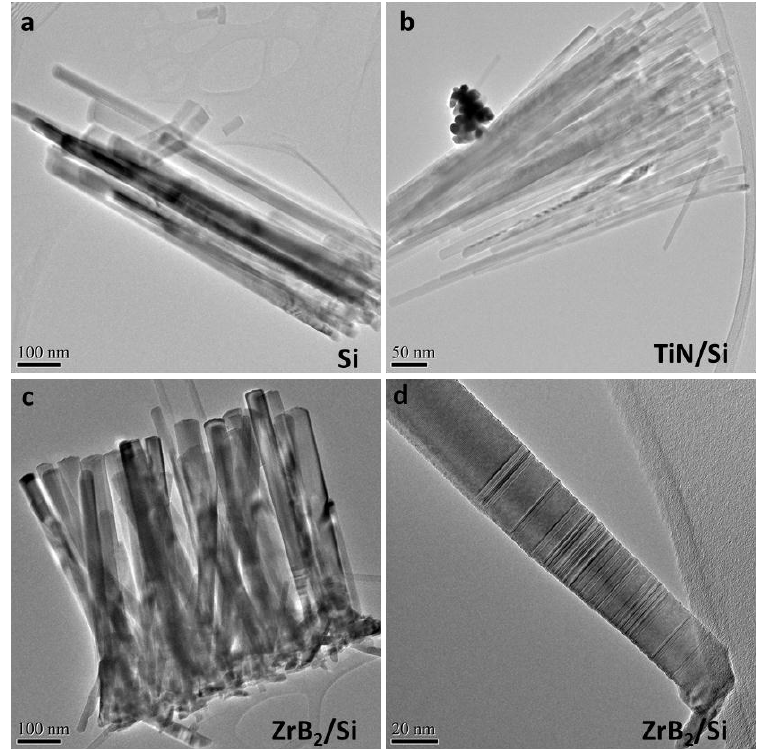
Figure 8. TEM images of free-standing GaN NRs grown on: ( a ) Si at 1000 °C, ( b ) TiN/Si at 900 °C, and ( c , d ) ZrB 2 /Si at 850 °C substrates, respectively.